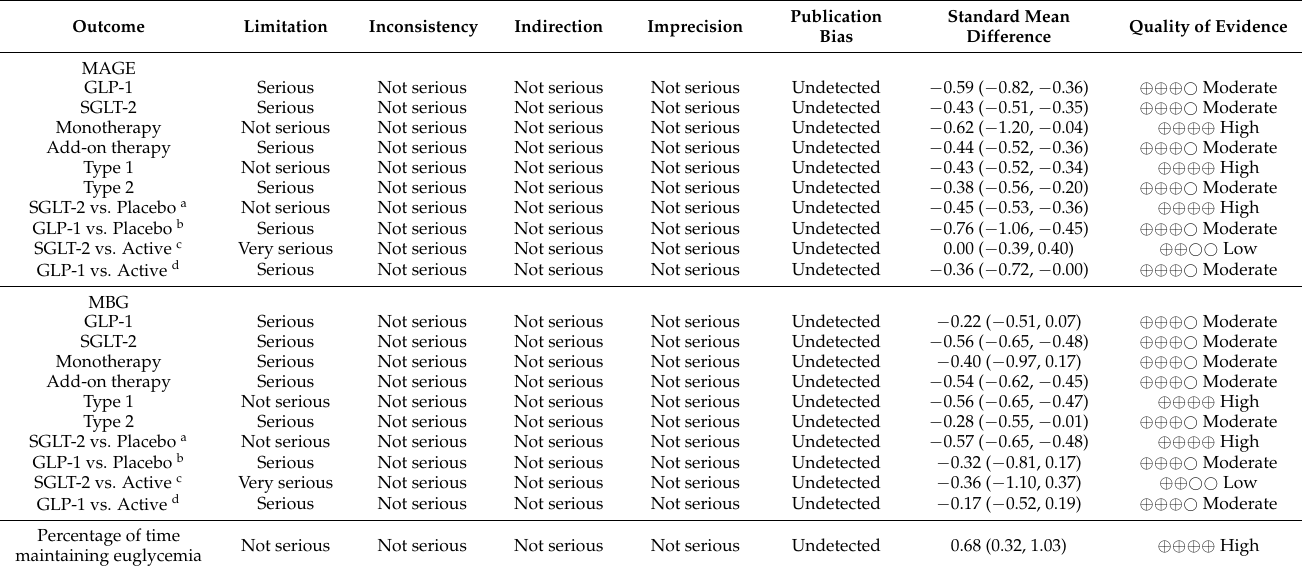
Figure 6. Effects of SGLT-2 inhibitors and GLP-1 agonists on the percentage of time maintaining euglycemia. CI, confidence interval; GLP-1, glucagon-like peptide 1; SGLT-2, sodium-glucose cotransporter 2. Green squares suggested measure of effect for each of included studies, and black diamond represented as meta-analyzed measure of effect. Bold letters indicated overall outcome. Table 2. Summary of findings for MAGE and MBG level reduction upon comparing interventions to comparators based on the GRADE